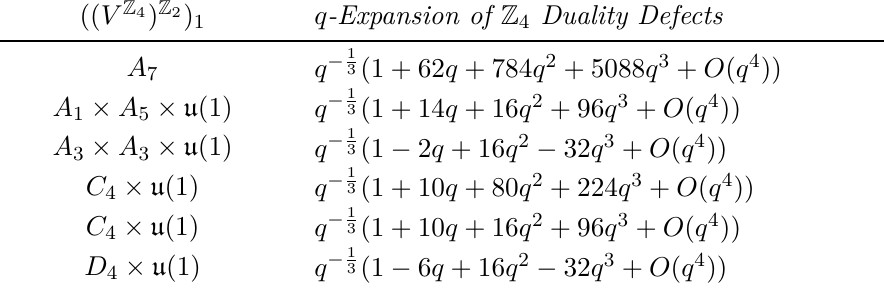
Table 6 . List of the defect partition functions of order 4, with defect twisting time. The first three come from the lattice automorphism ν (4)